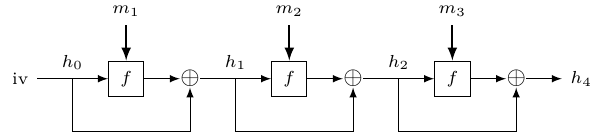
Figure 3.2: SHA-256 hash computation over a 3-block padded message m 1 ∥ m 2 ∥ m 3 = pad